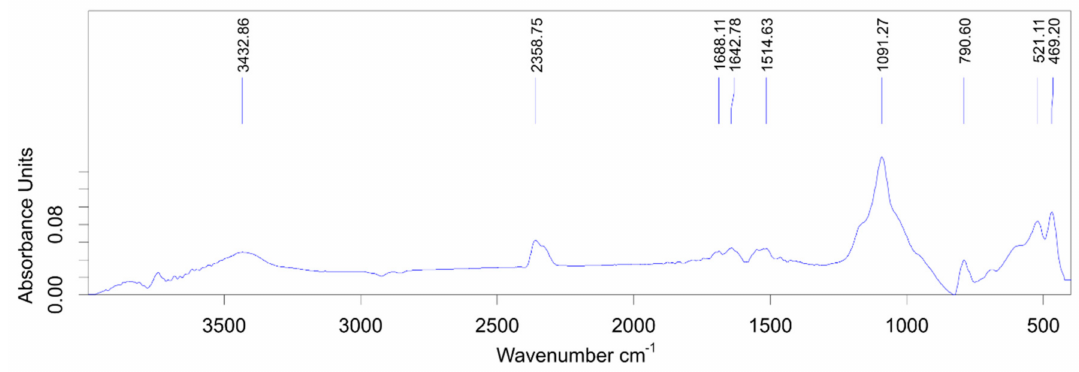
Figure 11. The infrared absorption spectrum of manganese ore from the Zhaksy